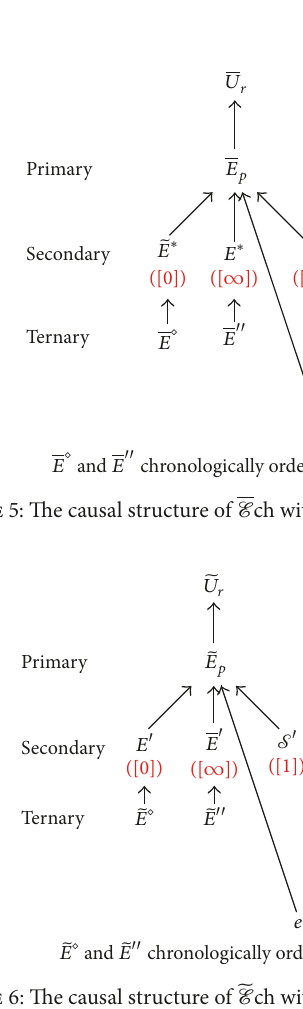
Figure 6: The causal structure of